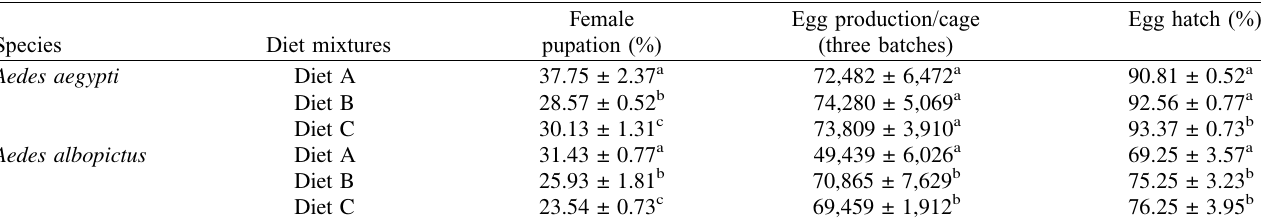
Table 3. Female pupation, fecundity, egg production and egg hatch rate of Aedes aegypti and Aedes albopictus reared with different larval